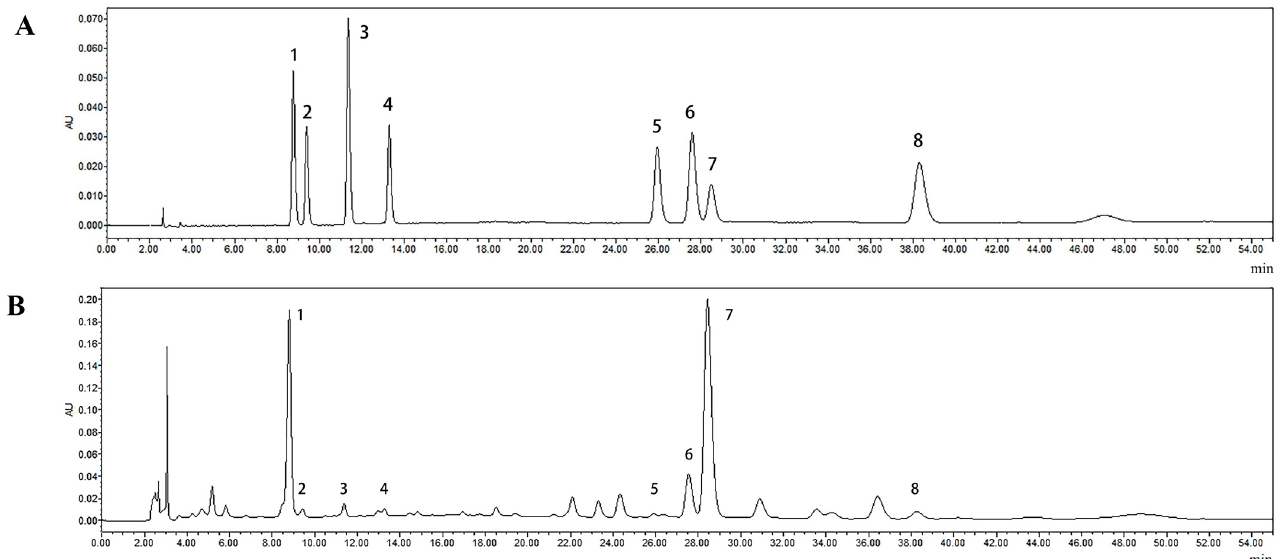
Figure 3. HPLC profile of phenolic acid mixed standard ( A ) and polyphenol samples ( B ). 1. Chloro- genic acid, 2. 4-dicaffeoylquinic acid, 3. caffeic acid, 4. 1,3-dicaffeoylqunic acid, 5. isochlorogenic acid B, 6. isochlorogenic acid A, 7. cynarin, 8. isochlorogenic acid C.